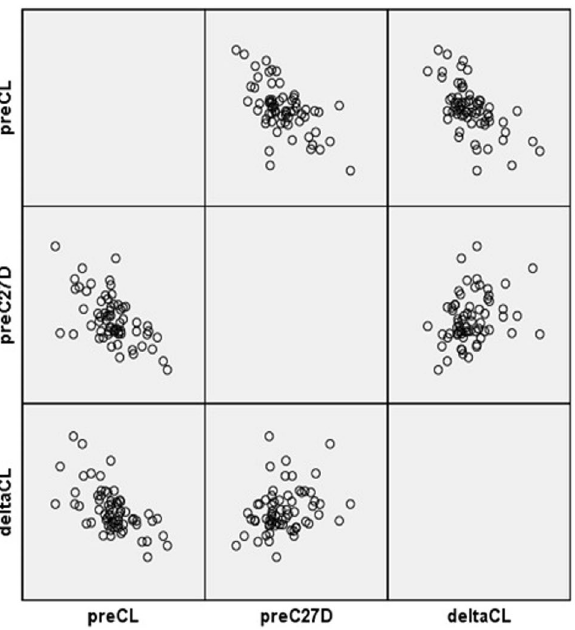
Figure 2. Scatterplot of preoperative CL and ΔCL. A significant negative correlation was found. Δ (delta), postoperative–preoperative value; CL, cervical lordosis.